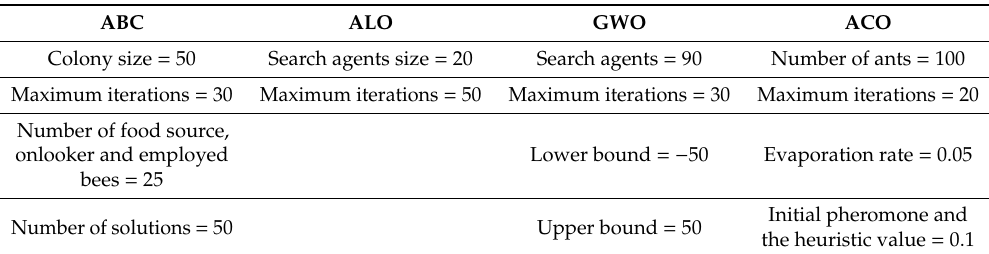
The parameter lists which achieved the best segmentation results for each bio-inspired